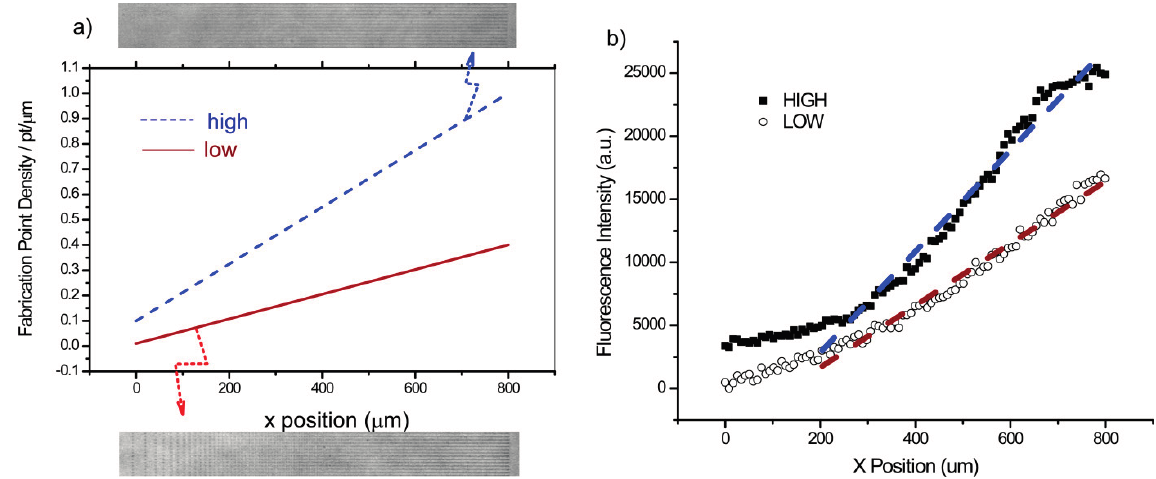
Figure 1. Design of the low and high slope gradients: ( a ) Linear ramp showing the design as a function of point density, along with the resulting phase contrast image of the fabricated gradients. ( b ) The resulting LN immunofluorescence and corresponding linear fit ( R 2 > 0.95) representing the relative